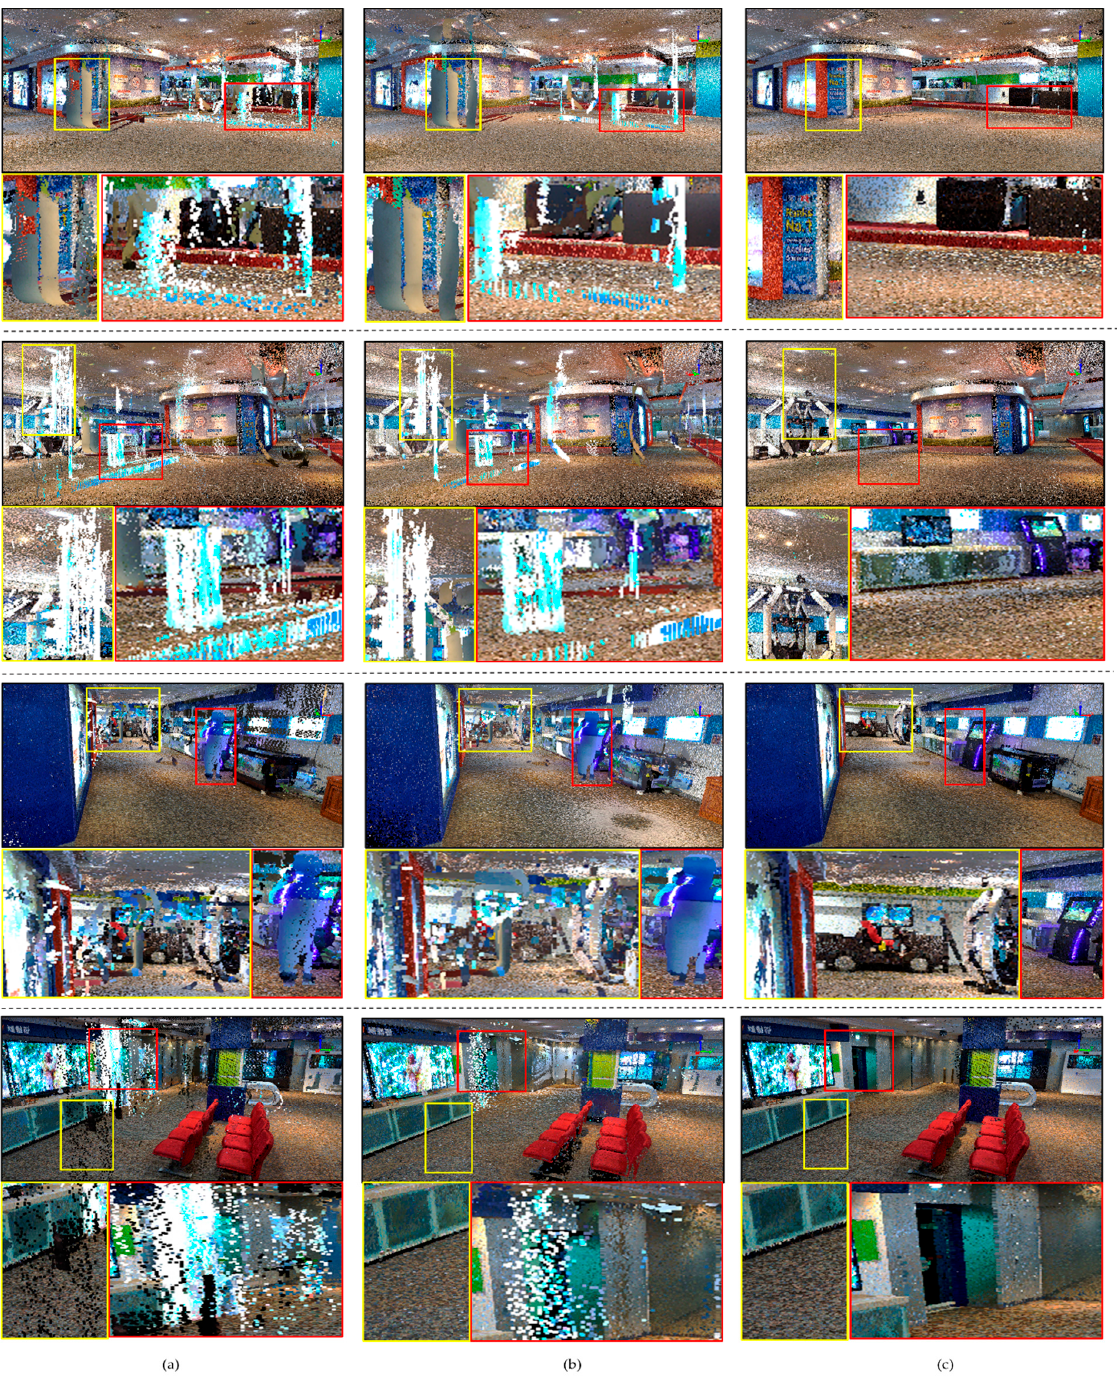
Figure 17. Comparison of the reflective noise results. ( a ) is the original point cloud image, ( b ) is the result after processing by FARO SENCE filter, and ( c ) is the result obtained by our method.